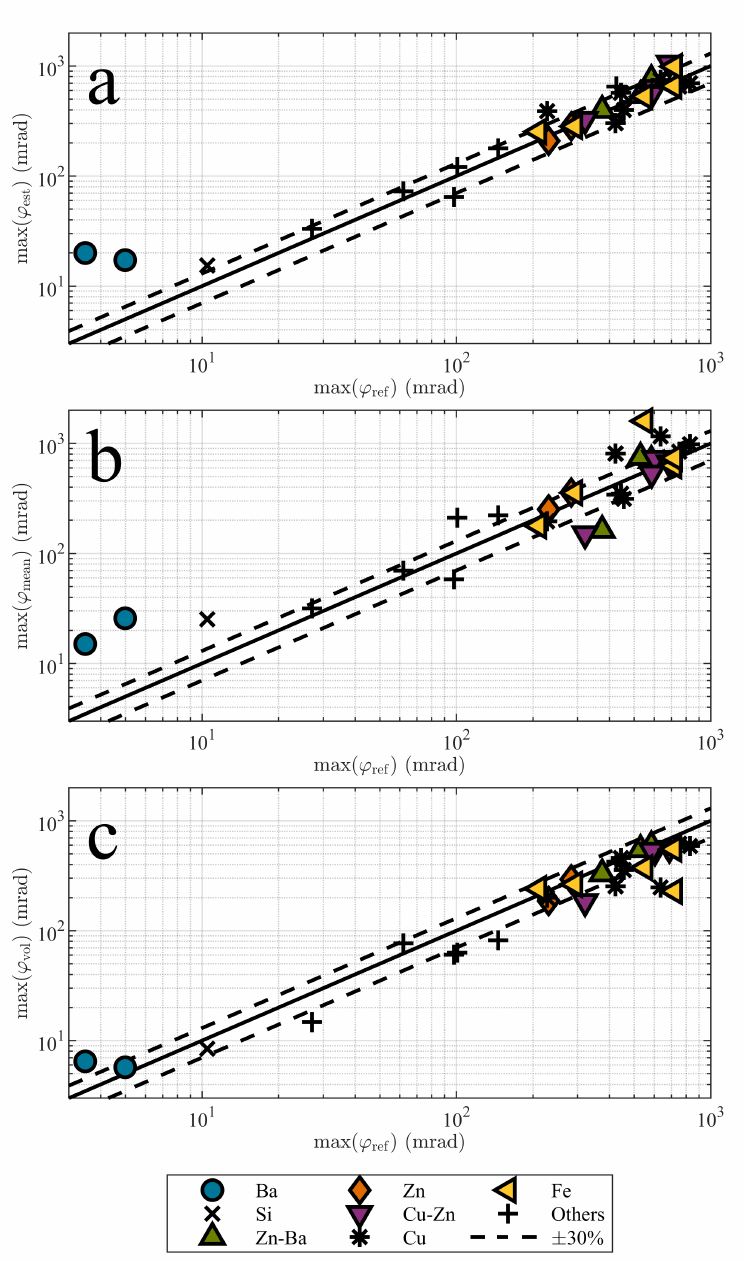
Figure 8. Maximum phase shift of estimated spectra vs. maximum phase shift of the reference spectra for all 30 samples. The legend follows the convention used in Spagnoli et al. [13]. ( a ) Estimation based on individual numerical simulation for each sample. ( b ) Estimation based on an average sample ( r = 1.3 cm, l = 3.876 cm). ( c ) Estimation based on the dilution factor according to the relative volume (Equation